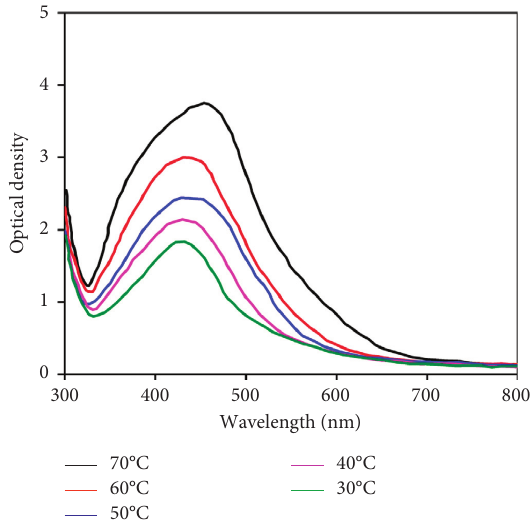
Figure 3: UV-vis absorption spectra of silver nanoparticles (Ag- NPs) recorded as a function of reaction temperature of 0.01M AgNO 3 solution with leaf extract. Reaction time: 120 min; extract volume: